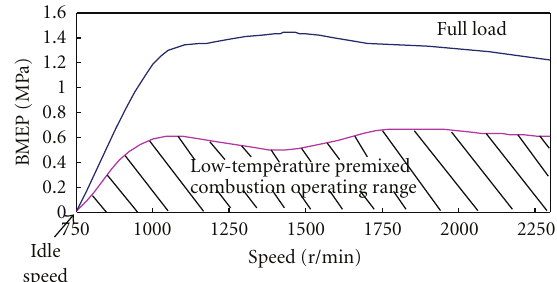
Figure 15: Operation range of low-temperature premixed combus-